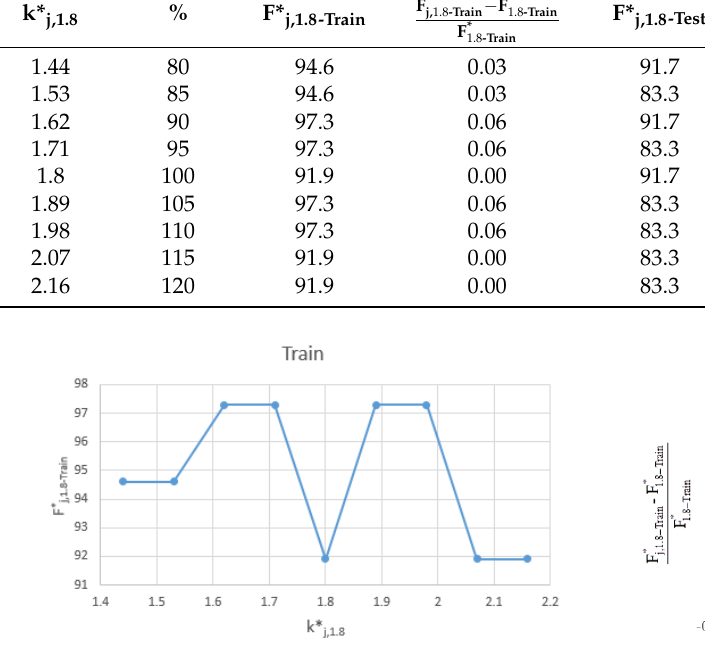
The values of F* j,1.8-Train , F* j,1.8-Test , F* j,1.8-Total and sensitivity function (F* j,1.8 − F* 1.8 )/F* 1.8 k* j,1.8 Table 7. Values of F* j, − 0-Train , F* j, 1.80-Test , and F* j, 1.80-Total by varying k* 1.80 in the fixed range.